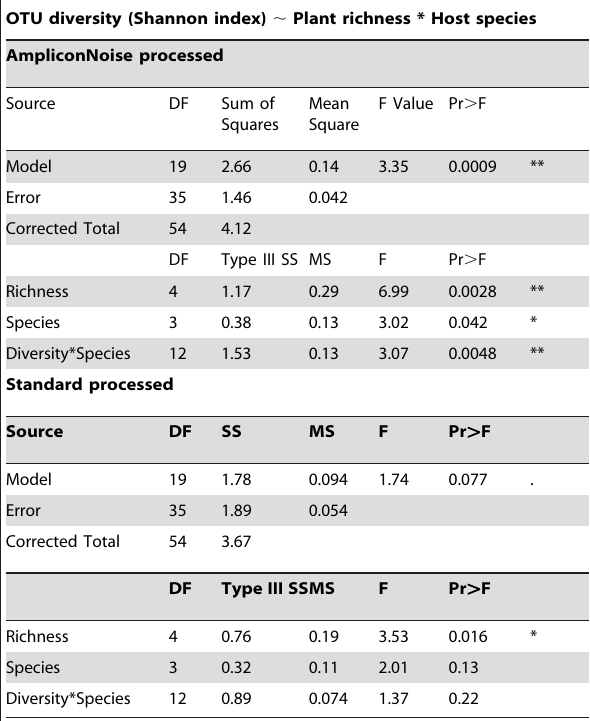
Table 2. ANOVA results tables for tests for differences in OTU diversity among two main treatment